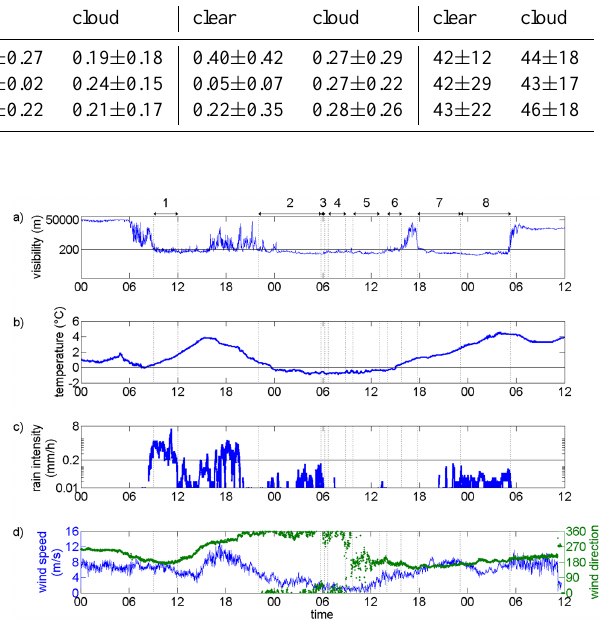
Figure 4. Time series of weather parameters observed during the cloud event on 22–24 October 2011. (a) Visibility, (b) temperature, (c) rain intensity, and (d) wind speed (left axis) and direction (right axis). Different periods described in the text are marked with dashed lines and also with numbered arrows above (a) (1, rainy; 2, clean; 3, paper mill; 4, clean 2; 5, heating plant; 6, southern 1; 7, southern 2; and 8, southern